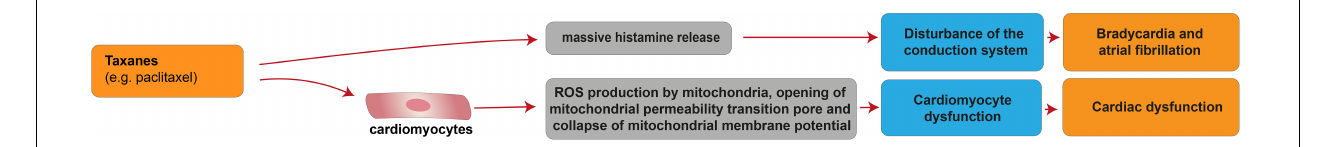
FIGURE 3 | Cellular and molecular mechanisms of the cardiotoxic effects exerted by taxanes. Schematic diagram showing the main cardiotoxic effects of taxanes, namely atrial fibrillation and cardiac dysfunction, as a result of the disturbance of the conduction system or cardiomyocyte dysfunction,